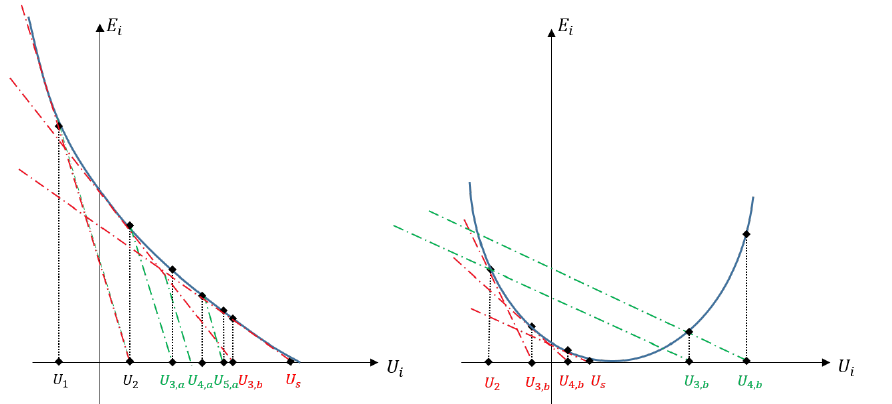
Figure 2. Model update in Newton